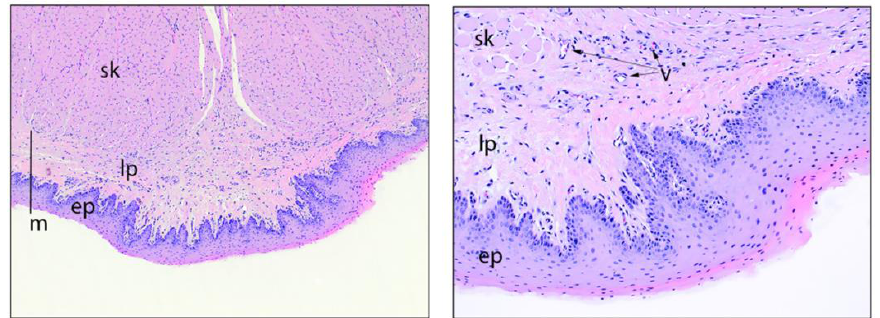
Figure 5. Left: tongue, ventral surface, 4x objective magnification. The ventral tongue near the midline appears microscopically normal after sublingual test article dosing. The dark bar denotes the two layers of the mucosa (m), which are the lamina propria (lp) and the epithelium (ep). sk = skeletal muscle fibers. Right: tongue, ventral surface, 10× objective magnification, at a higher magnification view of the mucosa, the lamina propria (lp) consists of wavy collagen fibers with occasional embedded arterioles and capillaries (v = vessels) but no notable leukocytic infiltrate. The epithelium (ep) is a stratified squamous and non-keratinized. sk = skeletal muscle fibers.